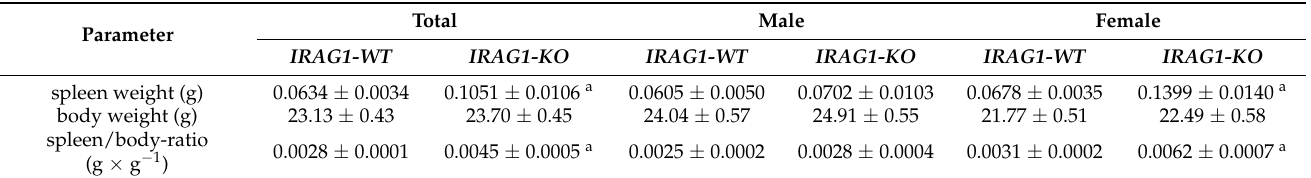
Table 1. Spleen weight, body weight and spleen-weight-to-body-weight ratio (spleen/body-ratio) of total (male and female), male and female IRAG1-WT and IRAG1-KO